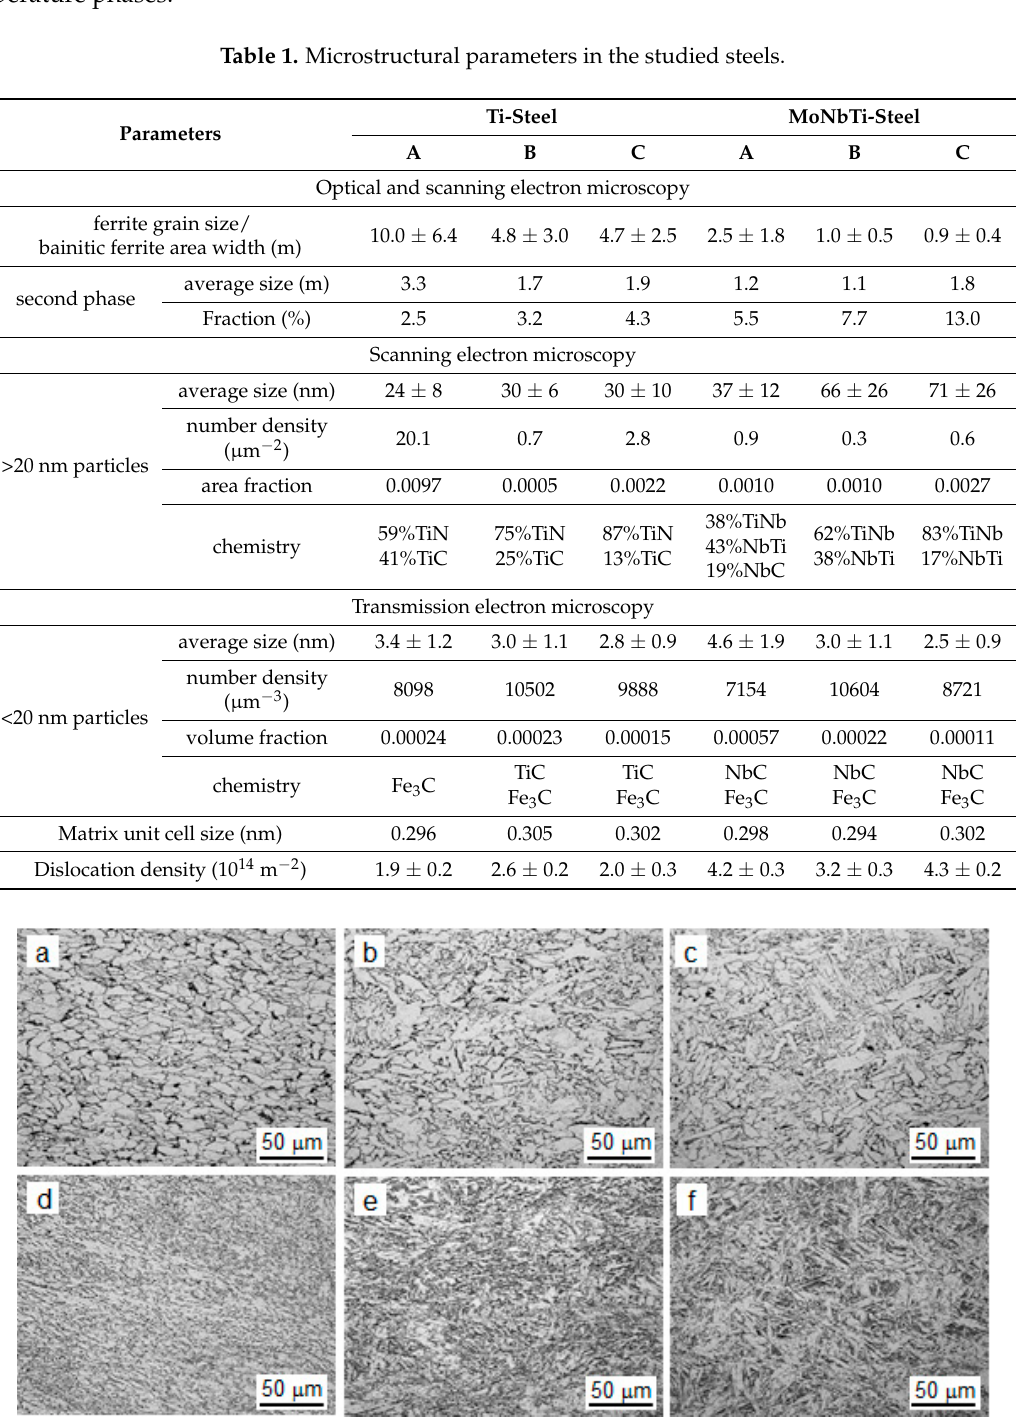
Figure 2. Optical images of microstructures in ( a – c ) Ti-steel and ( d – f ) MoNbTi-steel, after processing according to schedule ( a , d ) A, ( b , e ) B and ( c , f ) C (Figure 1).